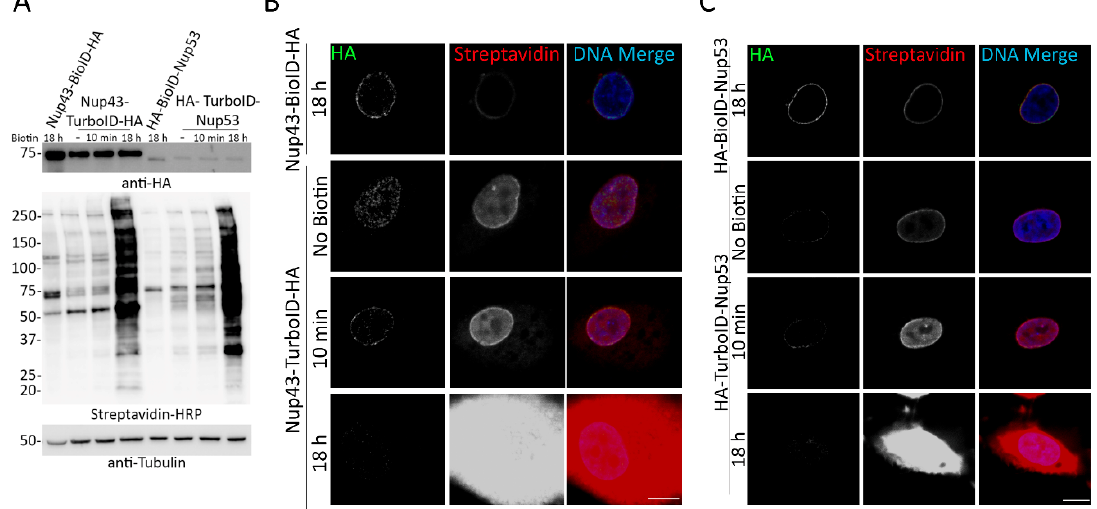
Figure 5. Nup43-TurboID-HA and HA-TurboID-Nup53 biotinylate without the addition of biotin. ( A )